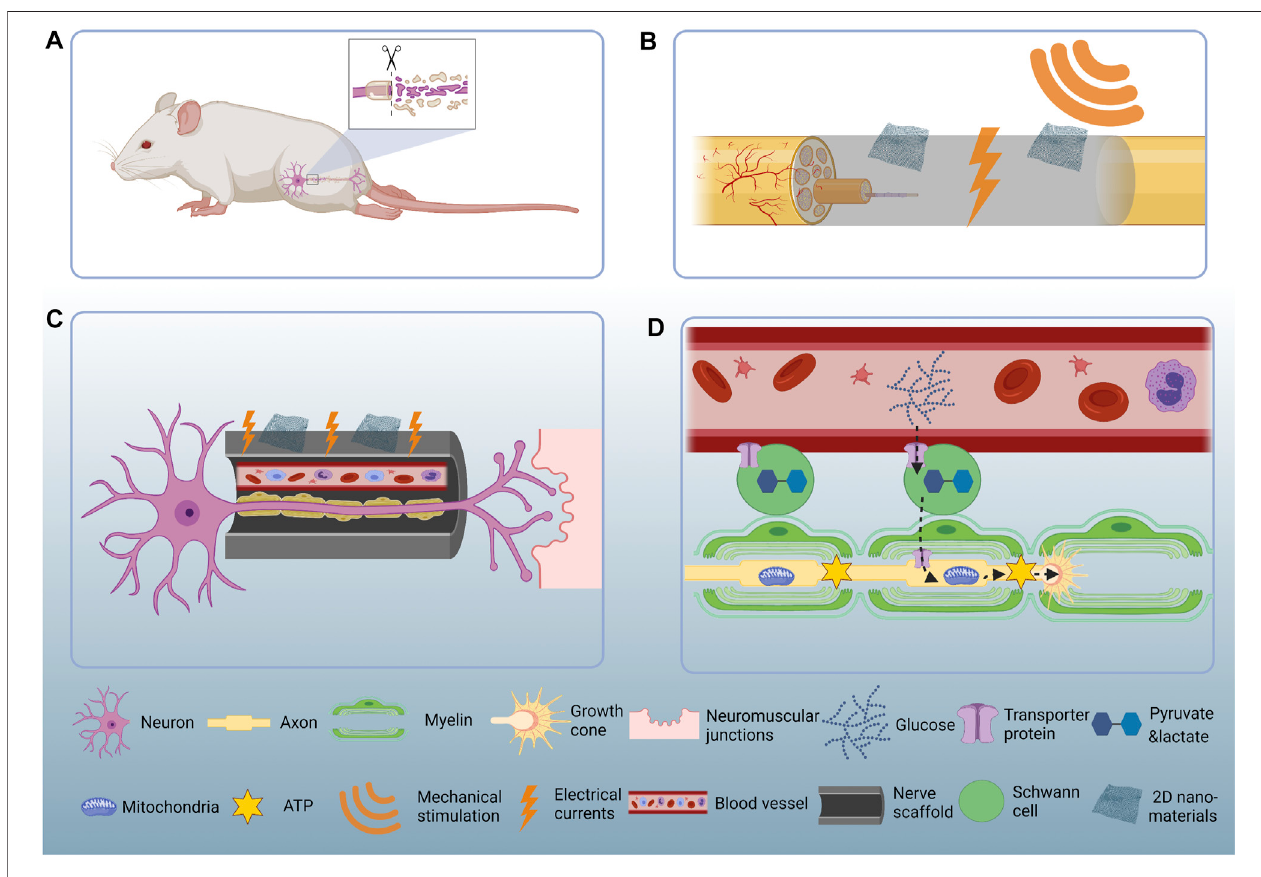
FIGURE 1 | Schematic illustration of the 2D nanomaterial mediated PNR. (A) PNI causes sensory and locomotor dysfunction. (B) Two-dimensional nanomaterials convert mechanical energy to electrical currents and thereby stimulate PNR. (C) Two-dimensional nanomaterials help rebuild the micro-vessels and guide the regeneratingnervesbacktotheiroriginaltargets. (D) GlucoseinthereconstructedcapillariesgettransportedtotheSchwanncellsandthengetprocessed intopyruvate and lactate. The pyruvate and lactate get transported to the regenerating axons and serve as metabolic substrate. The mitochondria accumulate at the axonal growth cone and consume pyruvate and lactate to produce ATP which could be directly used as cellular